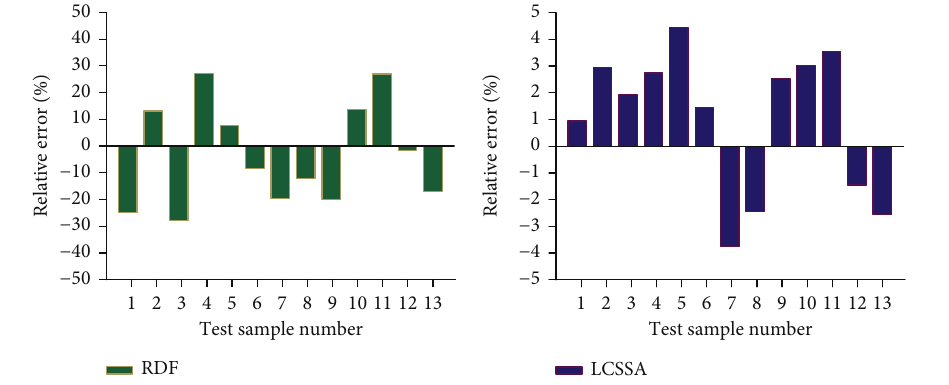
Figure 7: Phase space structure diagram of chaotic